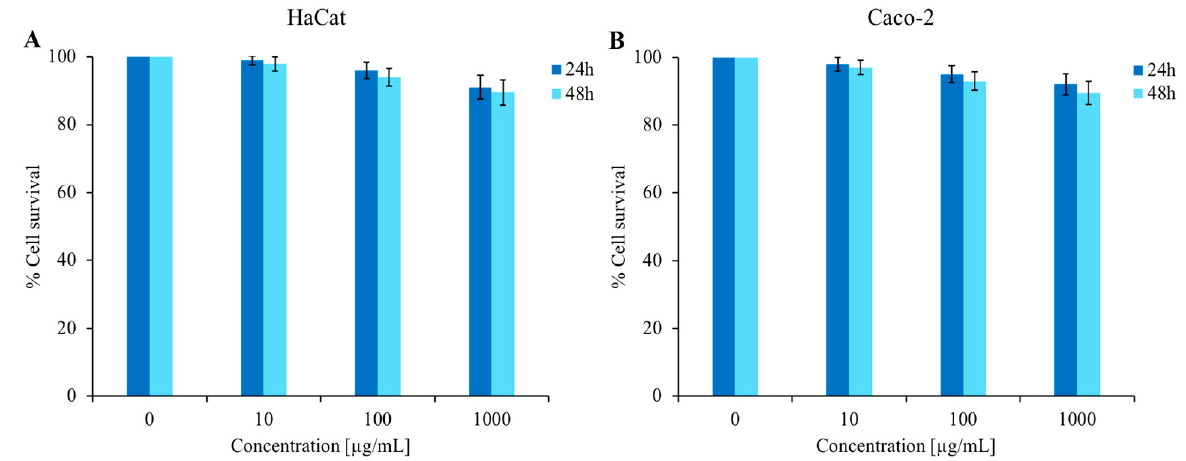
Figure 6. Determination of cytotoxic activity of C. aurantium ‘Crispifolia’ EO. Panel ( A ) shows the % cell survival of the HaCat cell line, while panel ( B ) shows the % cell survival of the Caco-2 cell line. Both cell lines were treated with different concentrations (x-axis) of EO for 24 and 48 h. % Cell survival is shown on the y-axis. The assays were performed in three independent experiments. Standard deviations are always less than 10%.